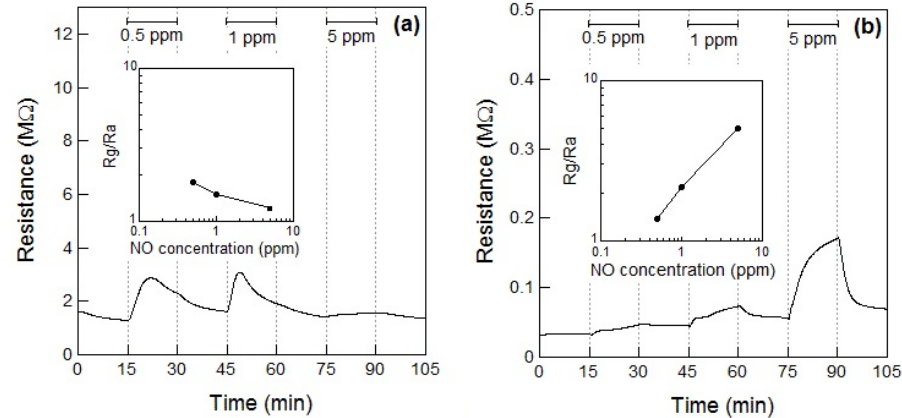
Figure 3. Response of the sensor element using WO (0, 0.5, 1, and 5 ppm) in air at ( a ) 100 °C and ( b ) 200 °C. The inset shows the relationship between the sensor response and NO